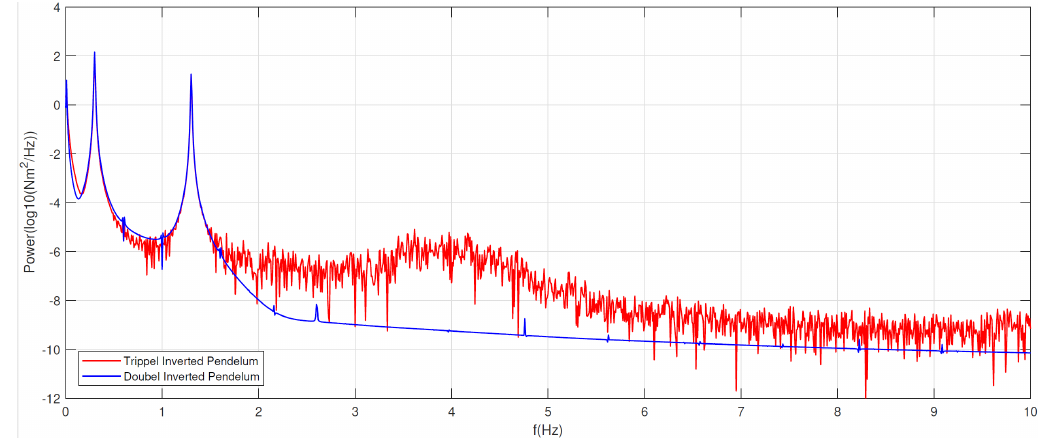
Figure 3. Comparison of the spectrum of a controlled TIP ‐ (red) and DIP ‐ model (blue).